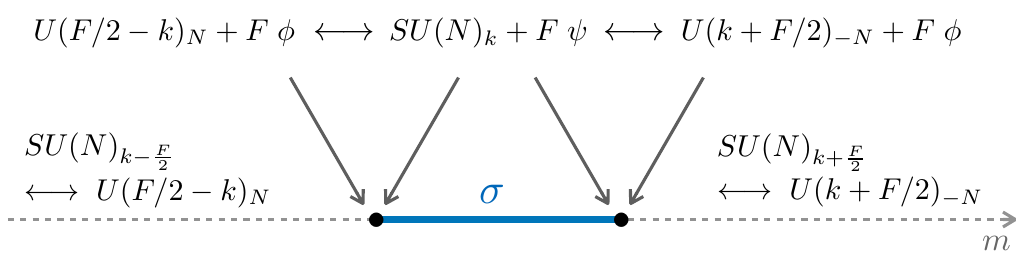
. g 2 the theory enters Figure 2 . Phase diagram of SU ( N ) k + F in the case k < F= 2. For j m j a quantum phase, with complex Grassmannian (1.1). The two phase transitions, at negative and positive mass, are described by two di(cid:11)erent bosonic